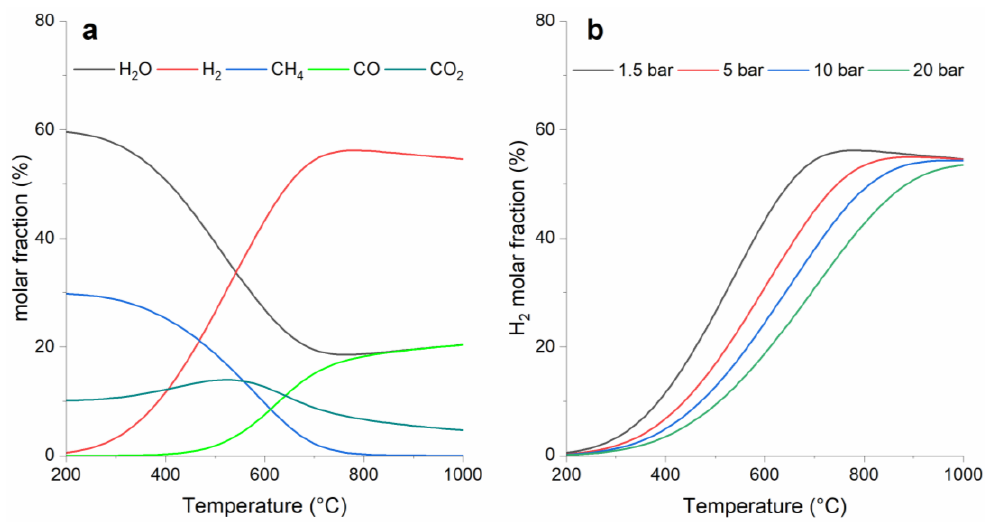
Figure 2. ESR equilibrium with stoichiometric inlet mixture: ( a ) effect of temperature on outlet composition at 1.5 bar and ( b ) H 2 outlet molar fraction vs. temperature at different pressures. The equilibrium was calculated via Gibbs free energy minimization.